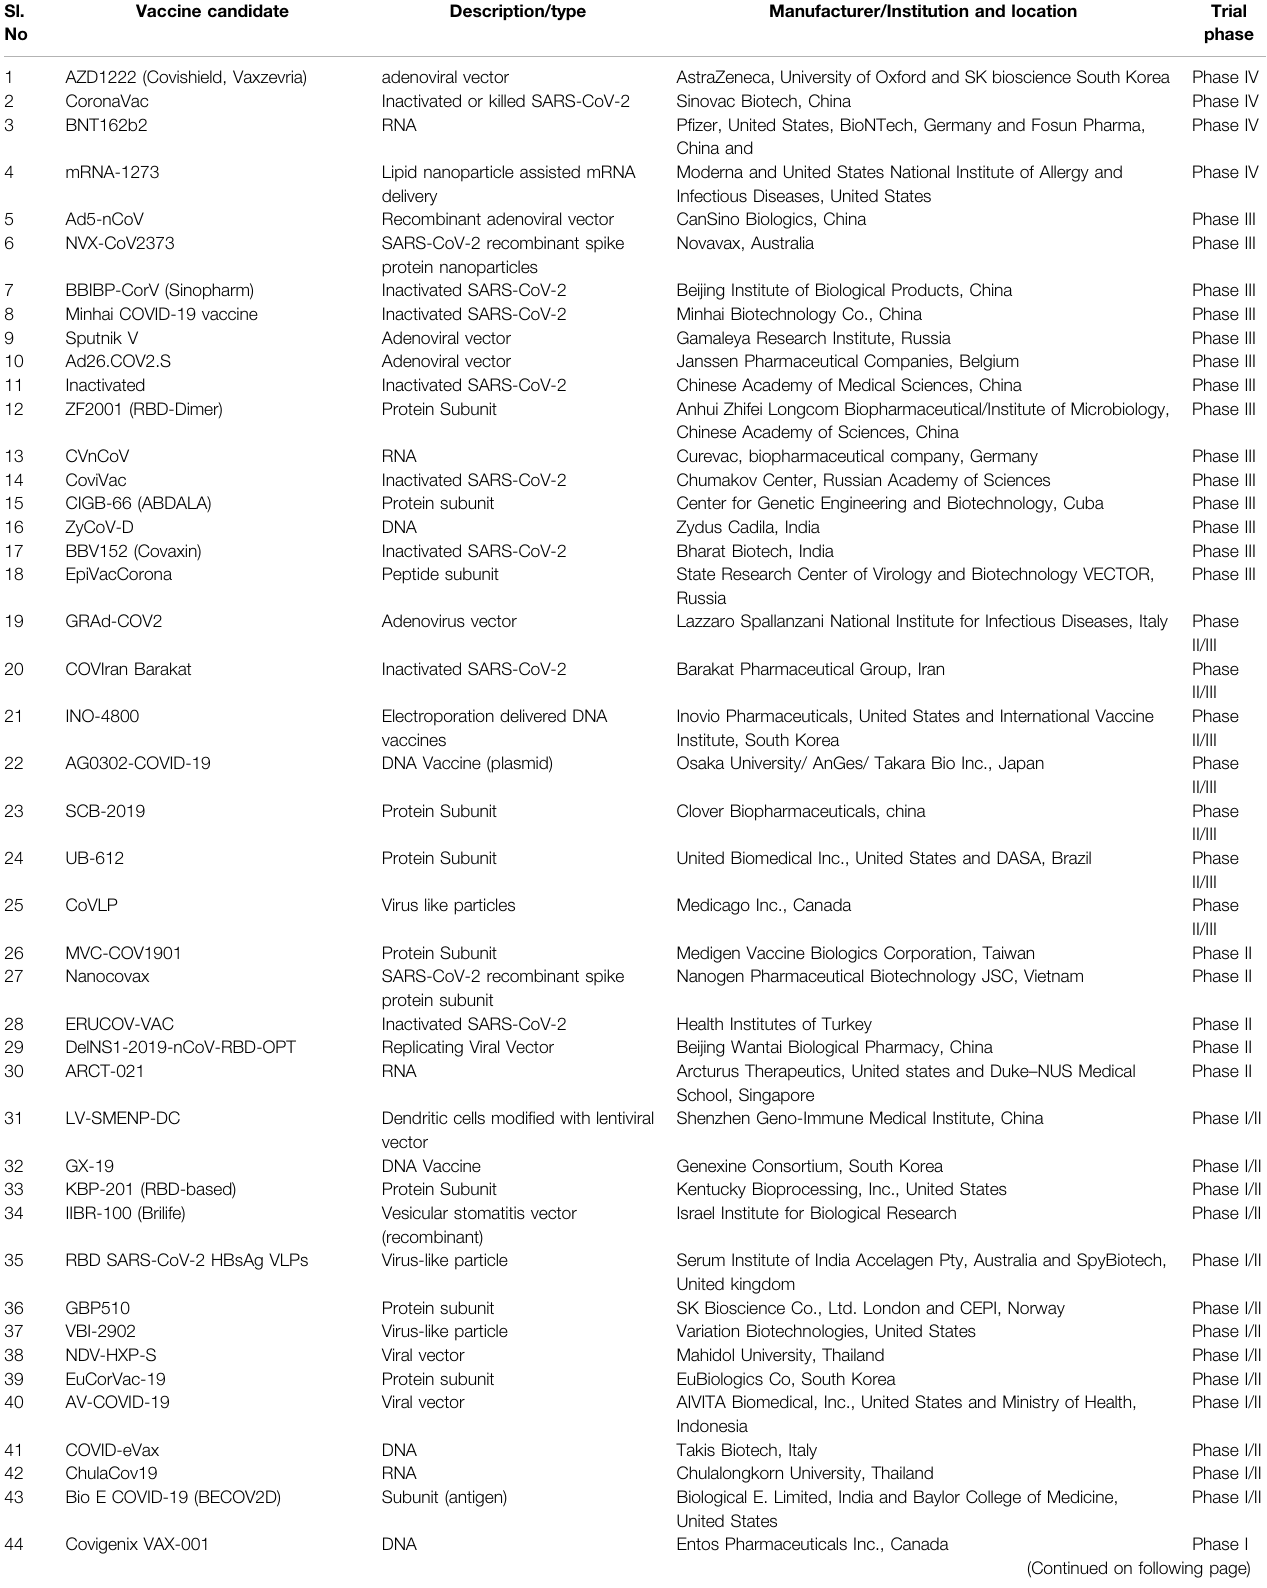
TABLE 2 | Vaccine candidates under investigation in the clinical trial of COVID-19. Sl.